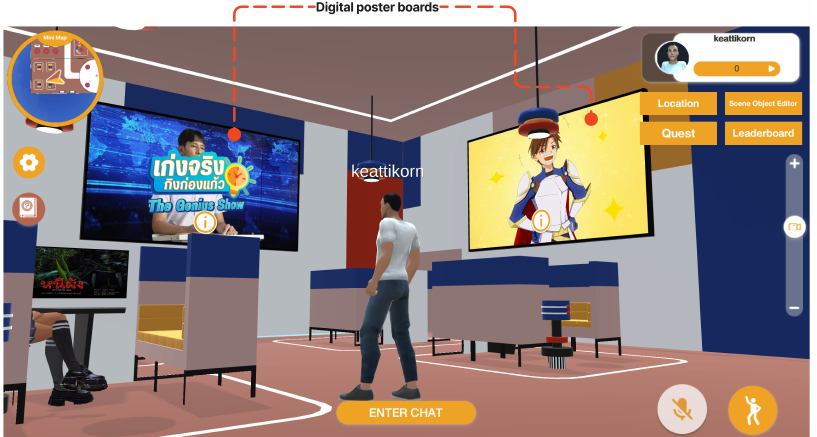
Figure 8. Animation and visual effects (ANI) department interior and the examples of two digital poster boards. The digital poster board on the left shows Thai text in correspondence to the English text displayed below as “The Genius Show”.